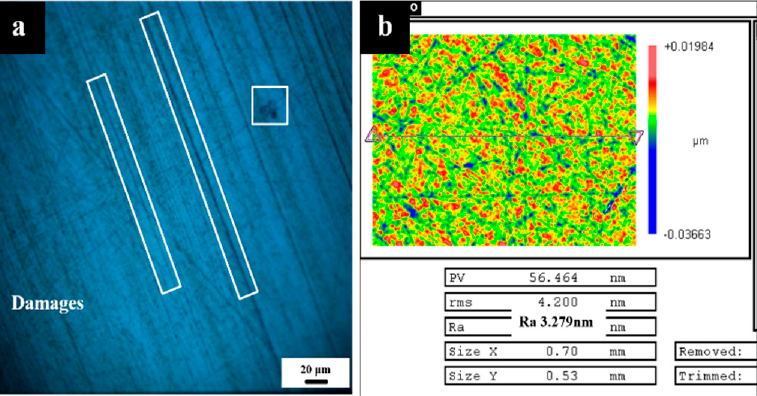
Figure 2. Crystal surface topography ( a ); and surface roughness ( b ) after pre-polishing.